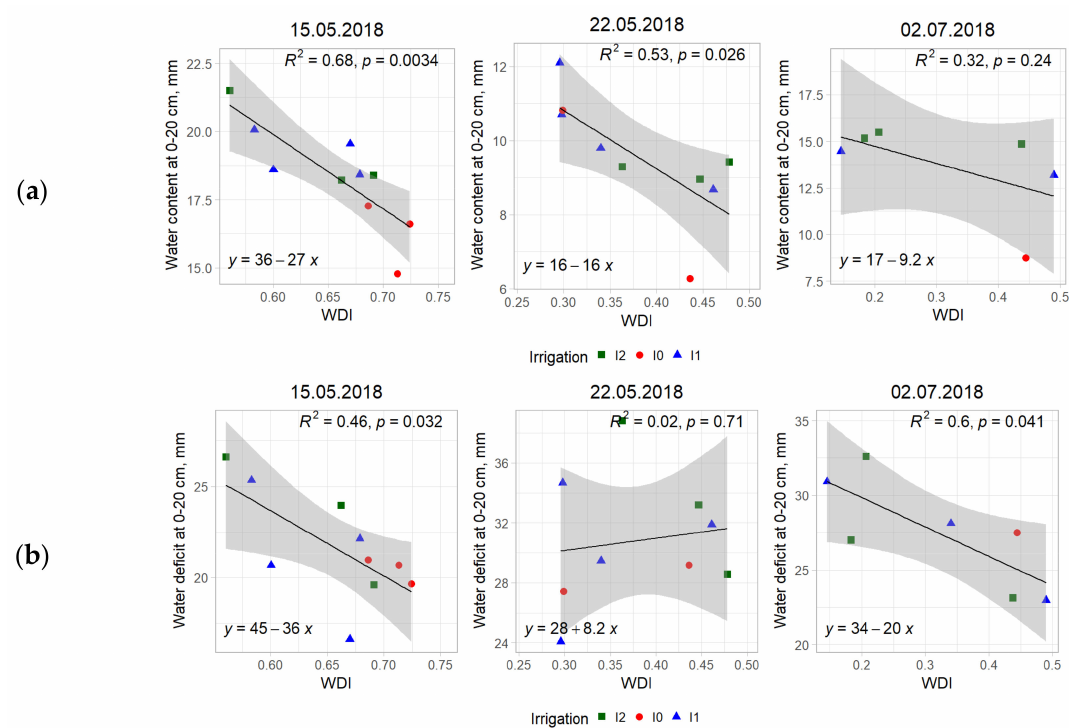
Figure 3. Correlation of the Water Deficit Index ( WDI ; mean per plot) with the topsoil water content ( a ) and deficit ( b ) for the winter wheat season in 2018 in Denmark. I0, I1 and I2 are minimum, optimum and full irrigation, respectively.